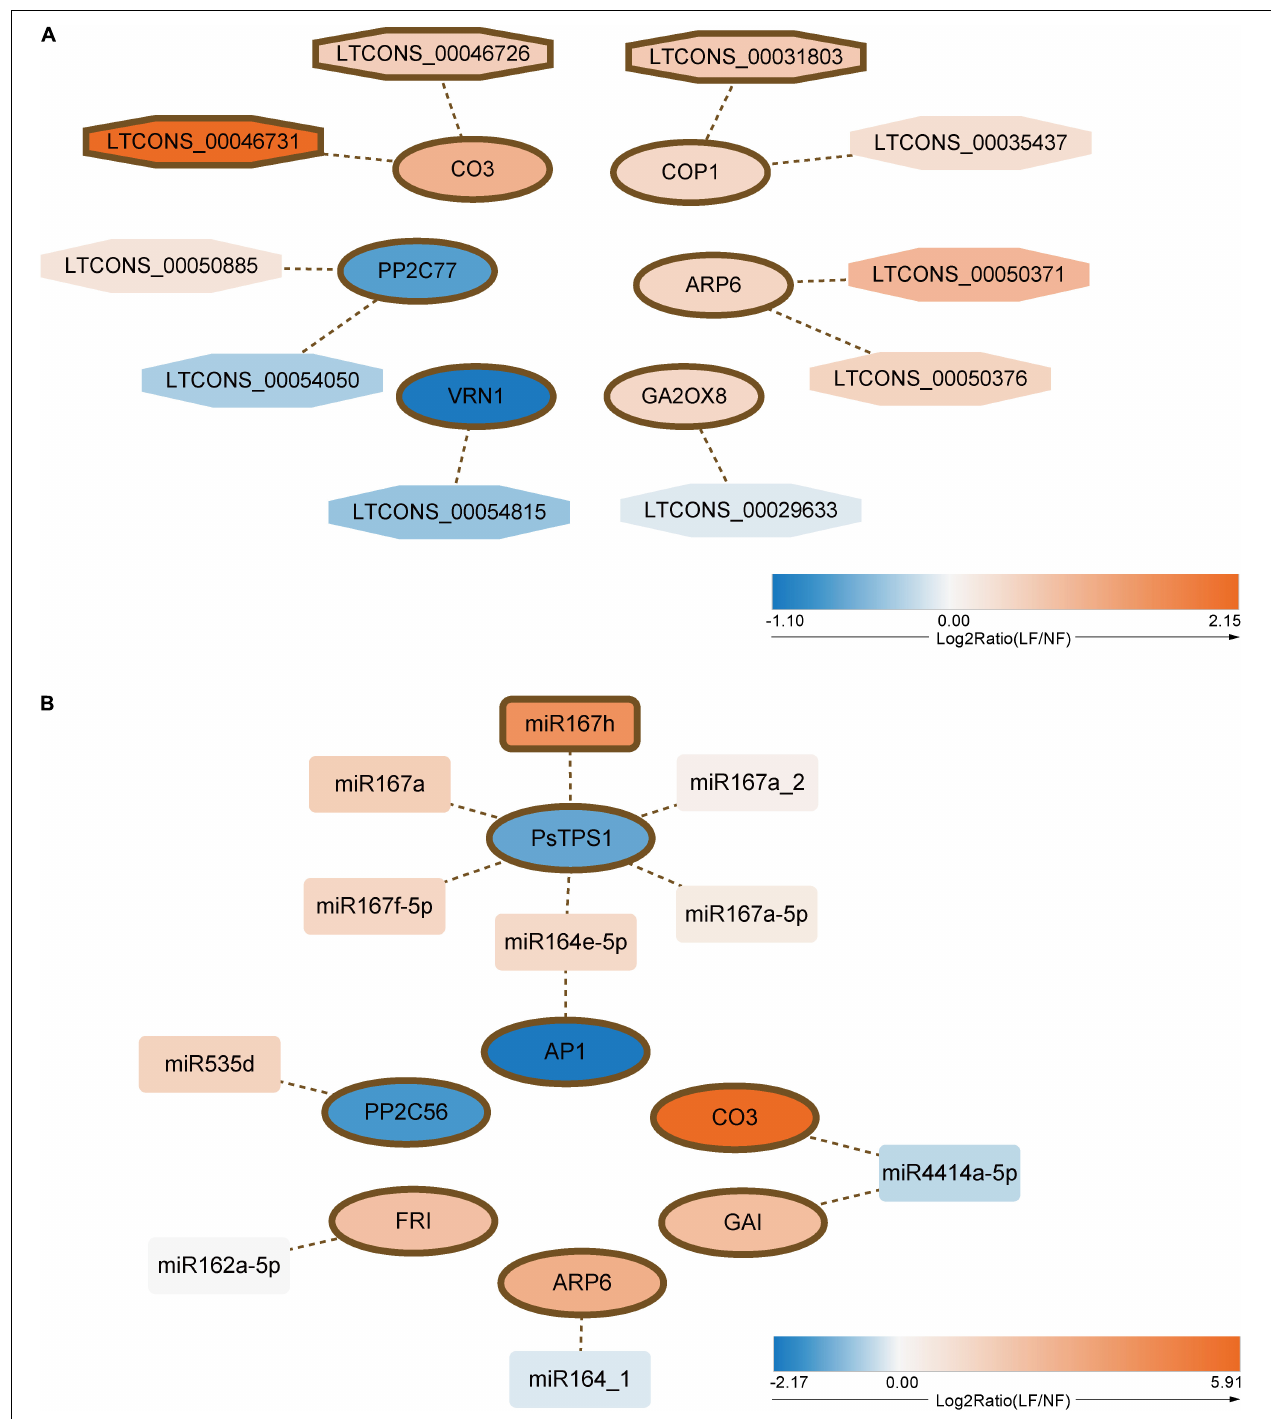
FIGURE 4 | Interaction networks of differential expression (DE) floral transition genes with (A) lncRNAs and (B) miRNAs. Ellipse, hexagon, and round rectangle indicated the mRNA, lncRNA, and miRNA, respectively. Arbitrary shape with thick border represented differentially expressed.